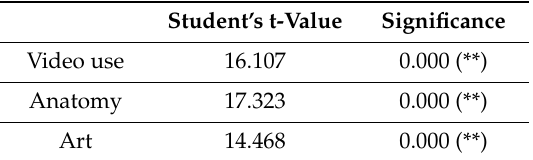
Table 4. Student’s t-values (note: ** = significant at p ≤ 0.01).